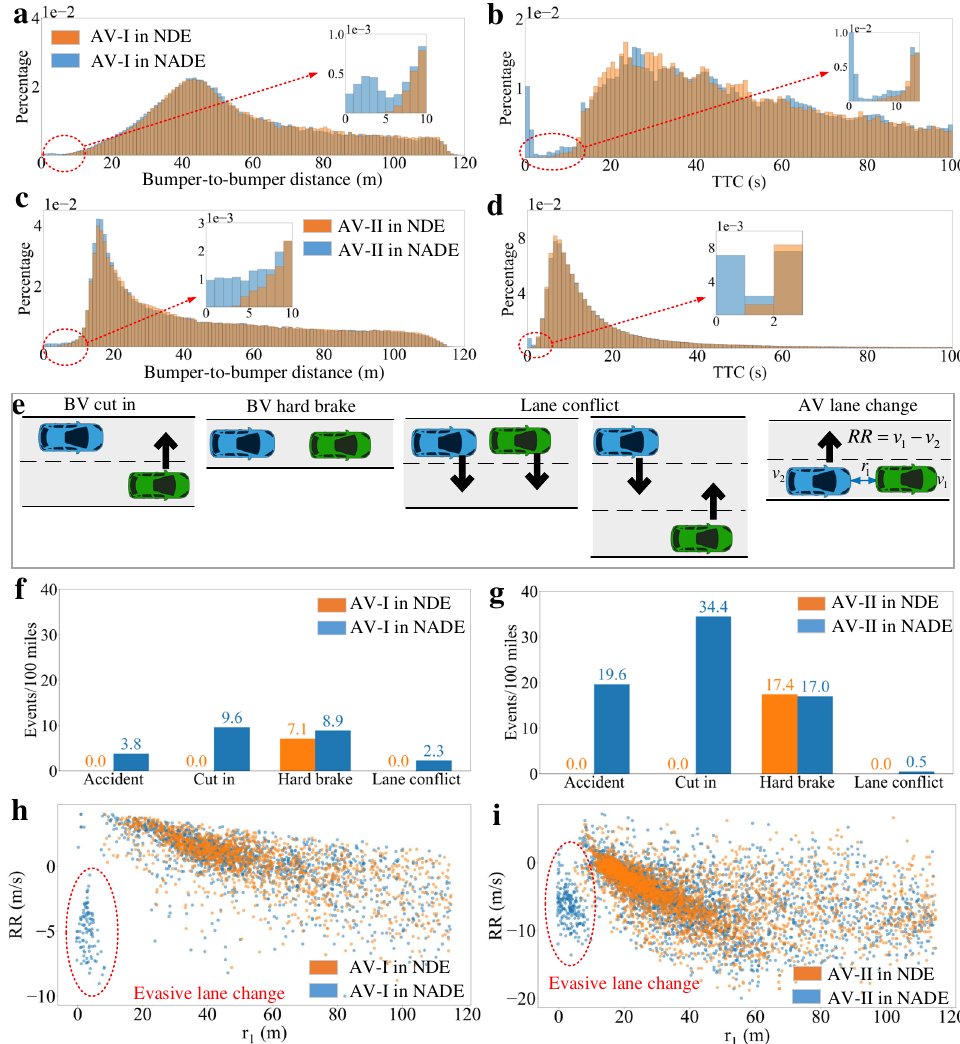
Fig. 6 Evaluation of the generated NADE. Distributions of bumper-to-bumper distance ( a ) and TTC ( b ) for the AV-I model. Distributions of bumper-to- bumper distance ( c ) and TTC ( d ) for the AV-II model. e Illustration of the events of background vehicle (BV, green vehicle) cut in, BV hard brake, lane con fl ict, and autonomous vehicle (AV, blue vehicle) lane change. The image of vehicles is previously published under the Creative Common CC0 1.0 Universal Public Domain Dedication at https://commons.wikimedia.org/wiki/File:C3top.png. The number of events encountered by the AV-I model ( f ) and the AV-II model ( g ) for every 100 miles. Distributions of lane changing events of the AV-I model ( h ) and the AV-II model ( i ), where the evasive lane change events are circled by the red dashed